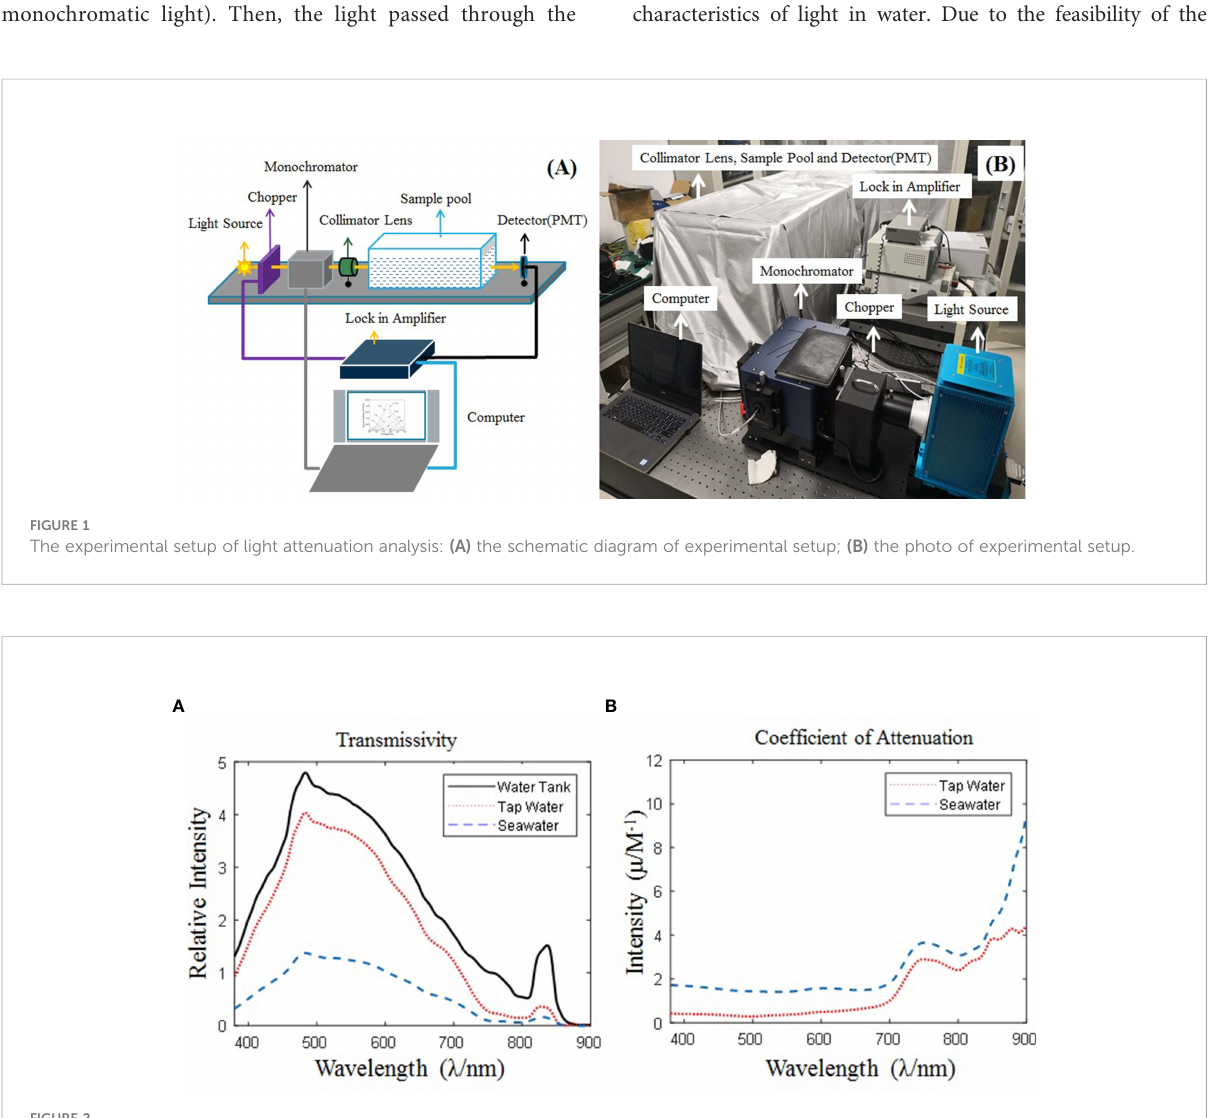
FIGURE 2 The analysis of light attenuation: (A) the transmittance of light in the vacant tank, tap water, and seawater; (B) the attenuation coef fi cient of light in tap water and